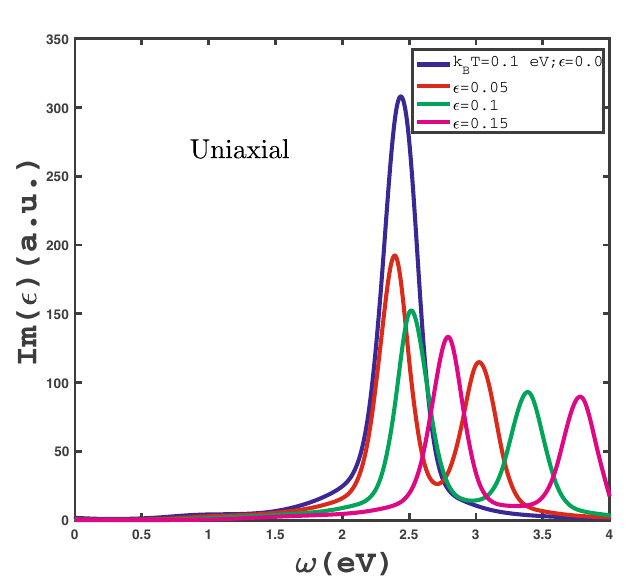
0.1 eV, 0.2 eV, 0.3 eV, 0.4 eV , in the B T =